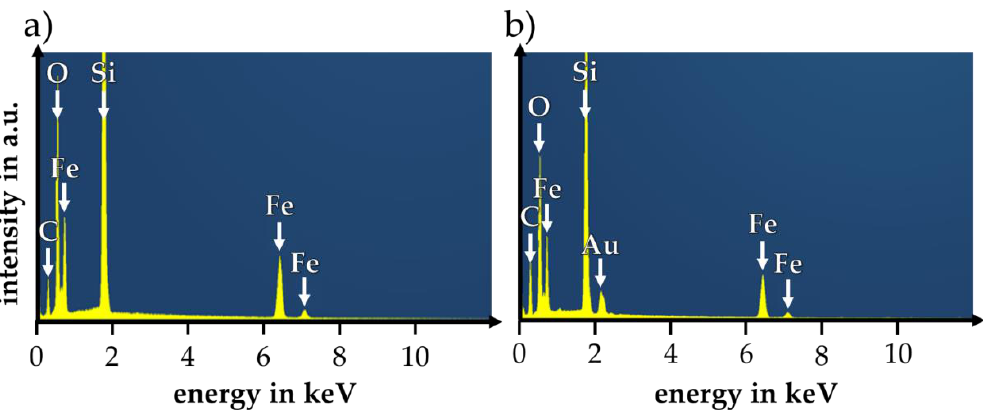
Figure A3. Magnetic separation of Au-SPIONs and Cit-Au-SPIONs after 8 h showed clear supernatants, which indicated that the gold was reduced onto the SPION cores instead of forming unattached nanosized gold that would appear red in the supernatant.